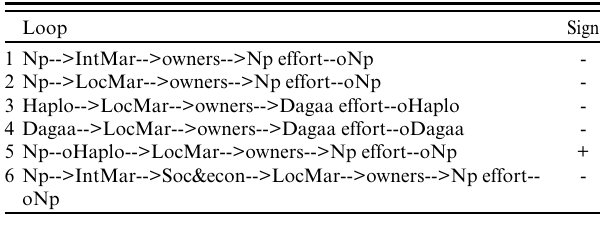
Table 3 . Exploitation loops and their signs. Np = Nile perch; IntMar = international market; Soc&econ = society and economy; LocMar = local and regional market; Haplo = haplochromines; Dagaa = Rastrineobola argentea ; --> = positive interaction; --o = negative